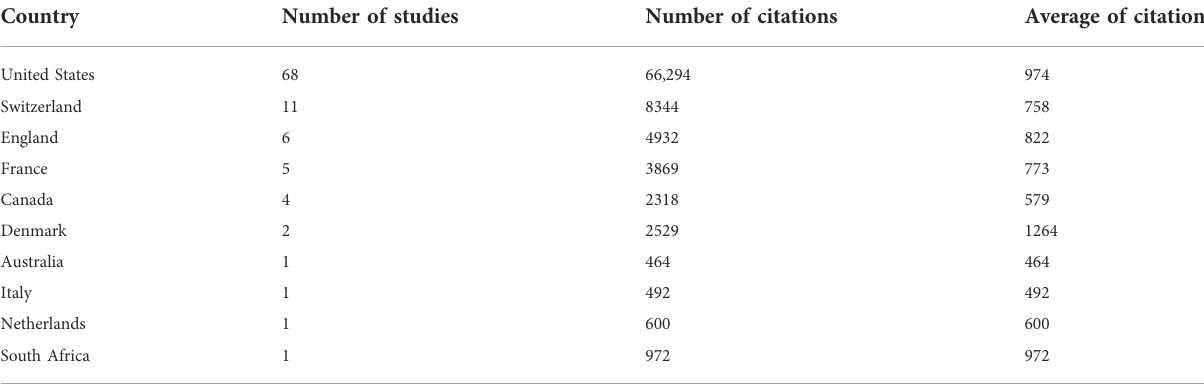
TABLE 1 Countries for the top 100 studies in drug therapy for the HIV fi eld.